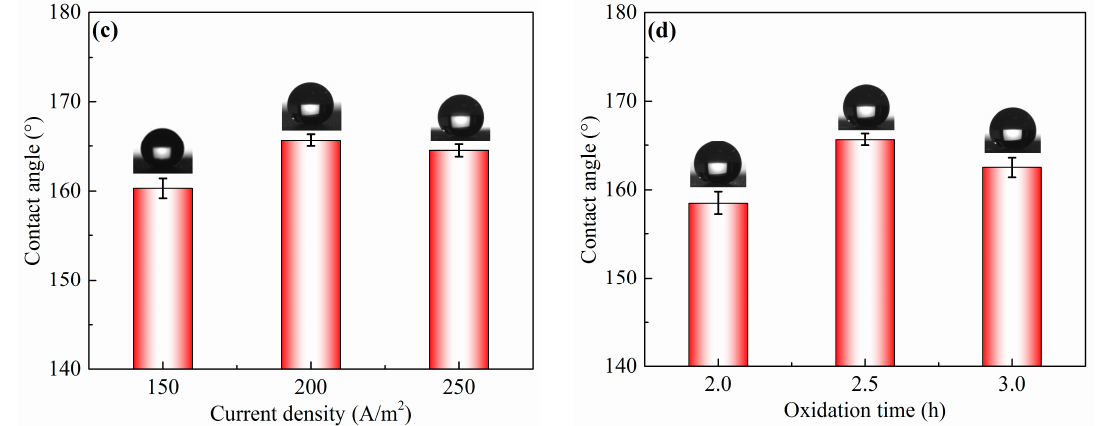
Figure 2. CA of sample surfaces obtained via electrochemical oxidation using different process parameters, such as ( a ) electrolyte concentration, ( b ) working voltage, ( c ) current density, and ( d ) oxidation time.